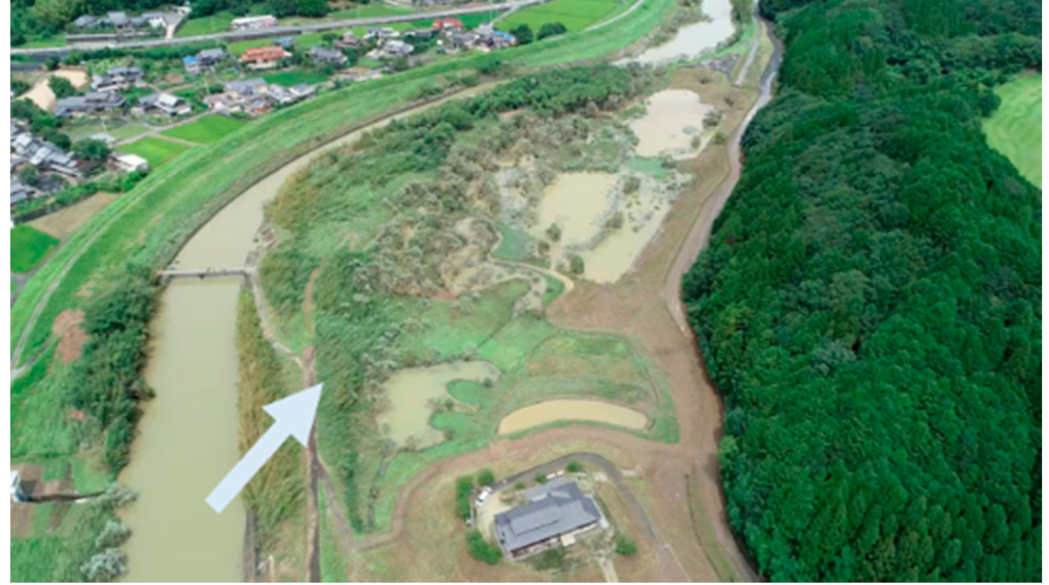
Figure 10. Azame-no-se immediately after